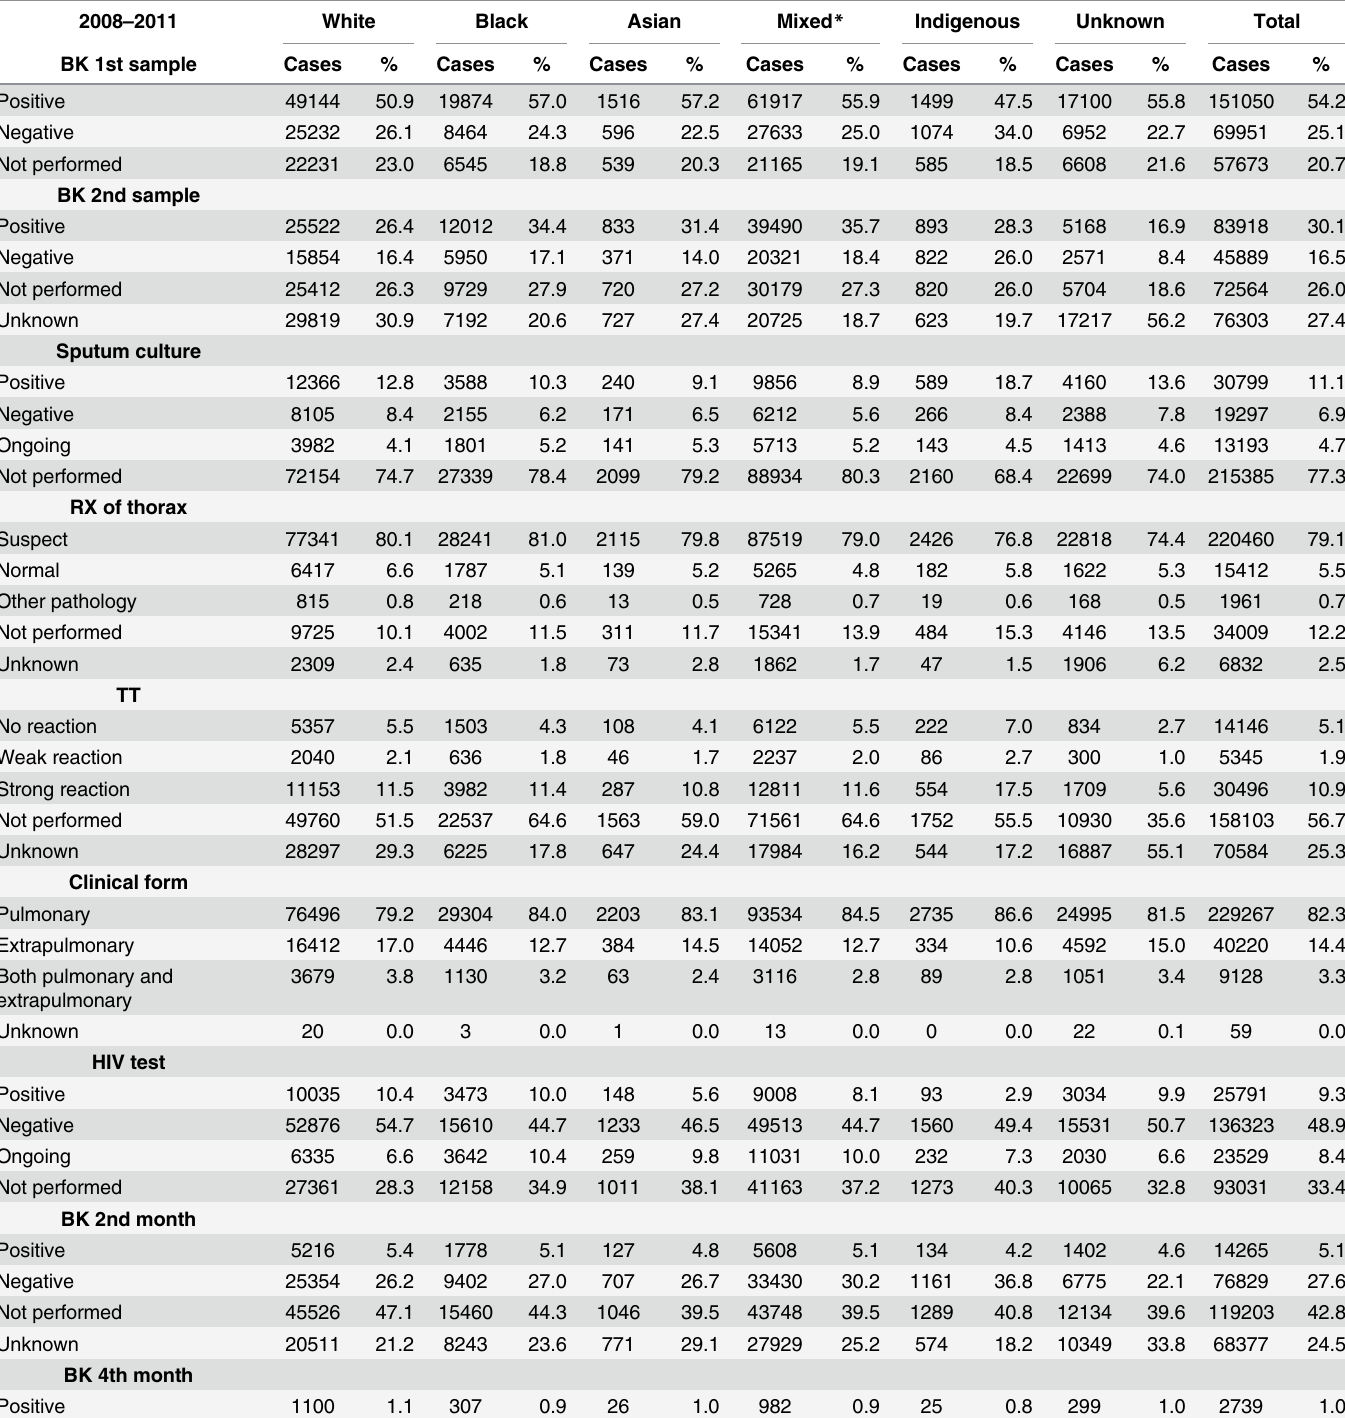
Table 3. Clinical-Epidemiological Characteristics and of Follow-up of New Cases of TB, by Clinical Form, Diagnostic Tests (Bacilloscopy, X-ray, Culture, Tuberculin Test, and HIV test), and Type of Entry, According to Colour or Race, Brazil, 2008 – 2011. Source: Sinan-TB/MS. BK =